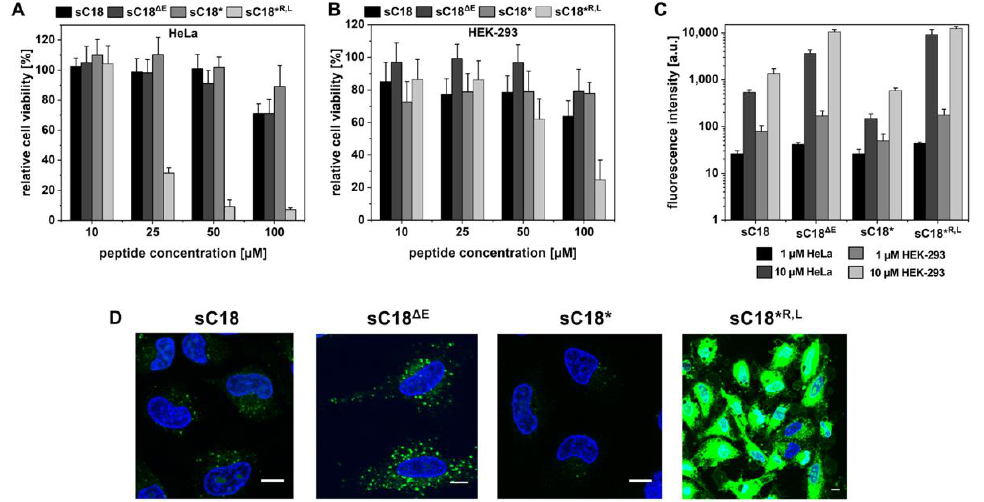
Figure 2. ( A,B ): Cytotoxicity profiles of the peptides in HeLa and HEK-293 cells. Cells were cultured and incubated at pH 7.4 for 24 h with different concentrations of peptide solutions. Untreated cells served as negative control; cells treated with 70% ethanol as positive control. Values from the positive control were subtracted from all data, and the untreated cells were set to 100%; assays were performed with n = 3 in triplicate. ( C ): Flow cytometry analysis of HeLa or HEK-293 cells after incubating 1 and 10 µ M peptide solutions for 30 min at 37 ◦ C; assays were conducted in triplicate n = 3. ( D ): Confocal laser scanning microscopy analysis of 10 µ M CF-labeled peptides after 30 min of incubation in HeLa cells. Green: CF-labeled peptides; blue: Hoechst 33342 nuclear stain; scale bar is 10 µ